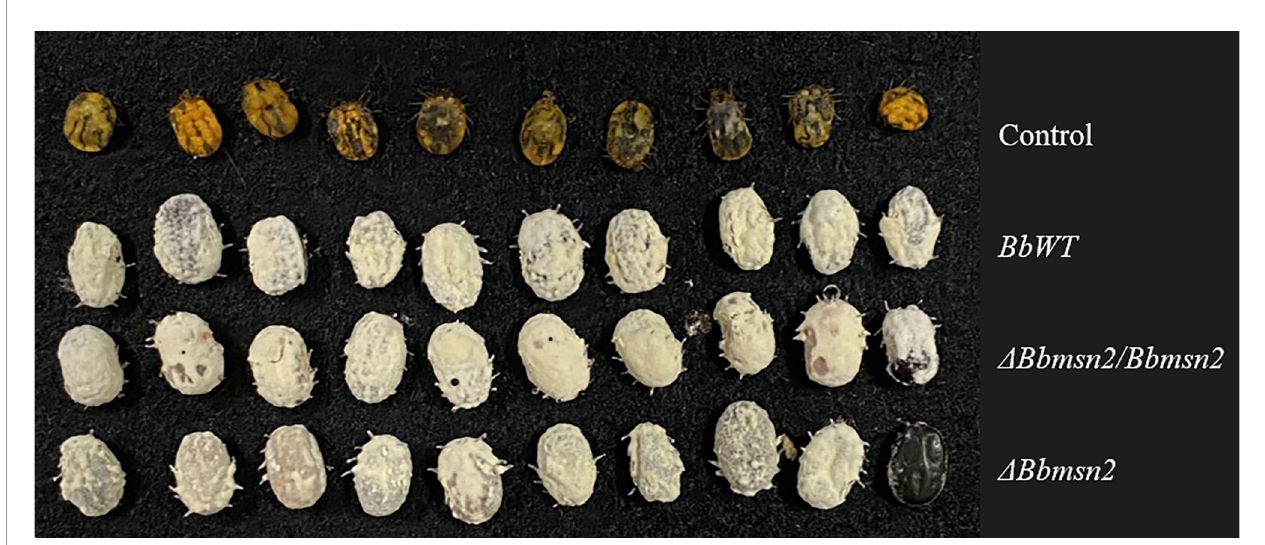
FIGURE 1 | Fungal sporulation on Rhipicephalus microplus engorged females ’ cadavers at day 5 post treatment by an intra-hemocoel injection with 5- m l conidial suspension at 2.0 × 10 8 conidia ml – 1